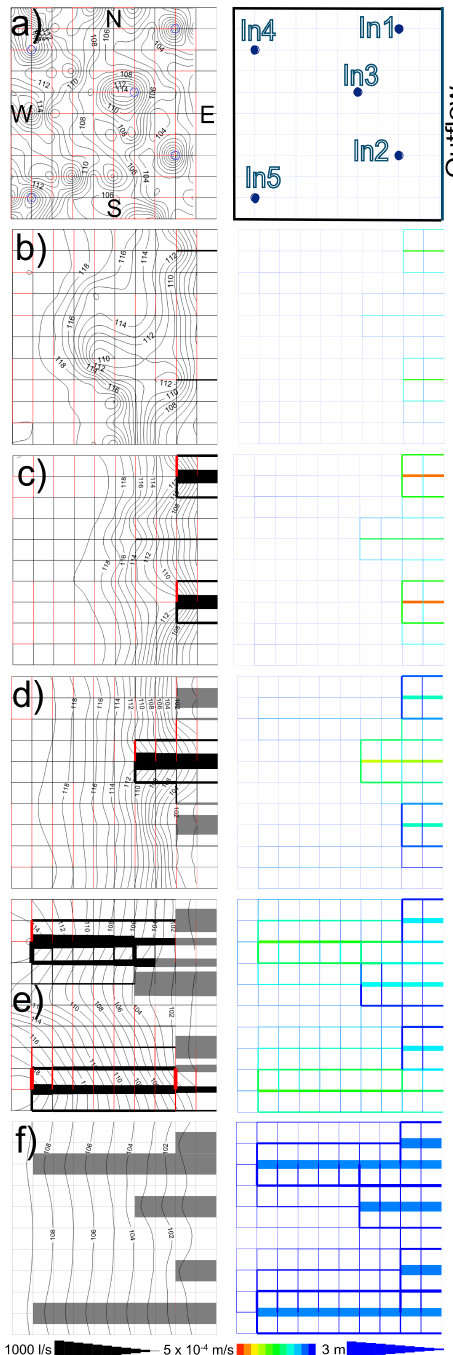
Figure 8. Six snapshots of the evolution of low-dip network with uniform initial diameters and inlet offsets. Left: flow rates (width) and flow direction (red = flow towards E or towards N, black/gray = flow towards W or towards S). Right: diameters (width) and widening rates (color). The codes below show thick- nesses, flow rates and widening rate. The values at the bar codes correspond to the thickest lines in the flow rate and diameter bars and to the warmest color in the bar for the widening rate. The scales are linear with the thinnest lines and dark blue colors representing no flow, no widening the and the smallest initial